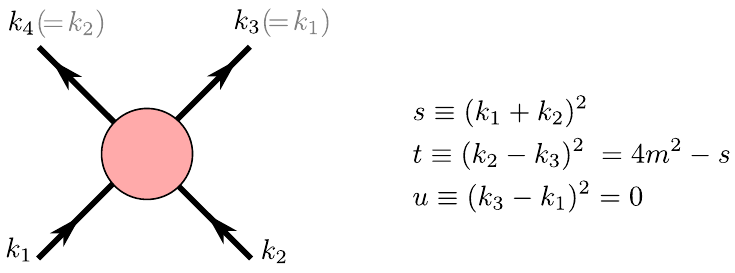
Figure 1 . The 2 2 S-matrix element. Time runs vertically in this (cid:12)gure. In two dimensions ! energy-momentum conservation implies there is only one independent Mandelstam variable such that S = S ( s ) with p s the centre of mass energy.